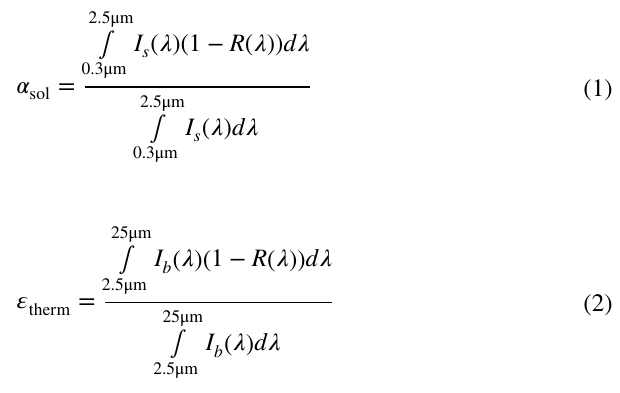
2 O 3 with different Sn